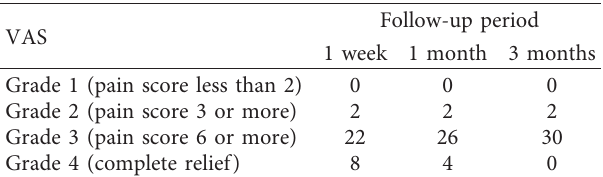
Figure 3: The VAS score was significantly decreased after PRF for 1d (1) and follow-up at 1 month (2), 2 months, (3) and 3 months (4) when compared to pre-PRF baseline (0). ∗ p < 0 . 001 indicates pre- PRF vs. post-PRF. Table 2: The number of patients in each grade at different time points after PRF ( n �